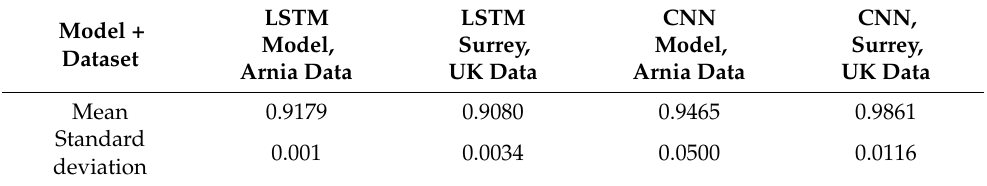
Table 4. Summary Accuracy statistics for the LSTM and CNN models of the original dataset and the Cobham, Surrey dataset we tested our models on. For the original Arnia data, we used 10-fold cross-validation statistics, and 30 samples from the Surrey dataset were used to test our